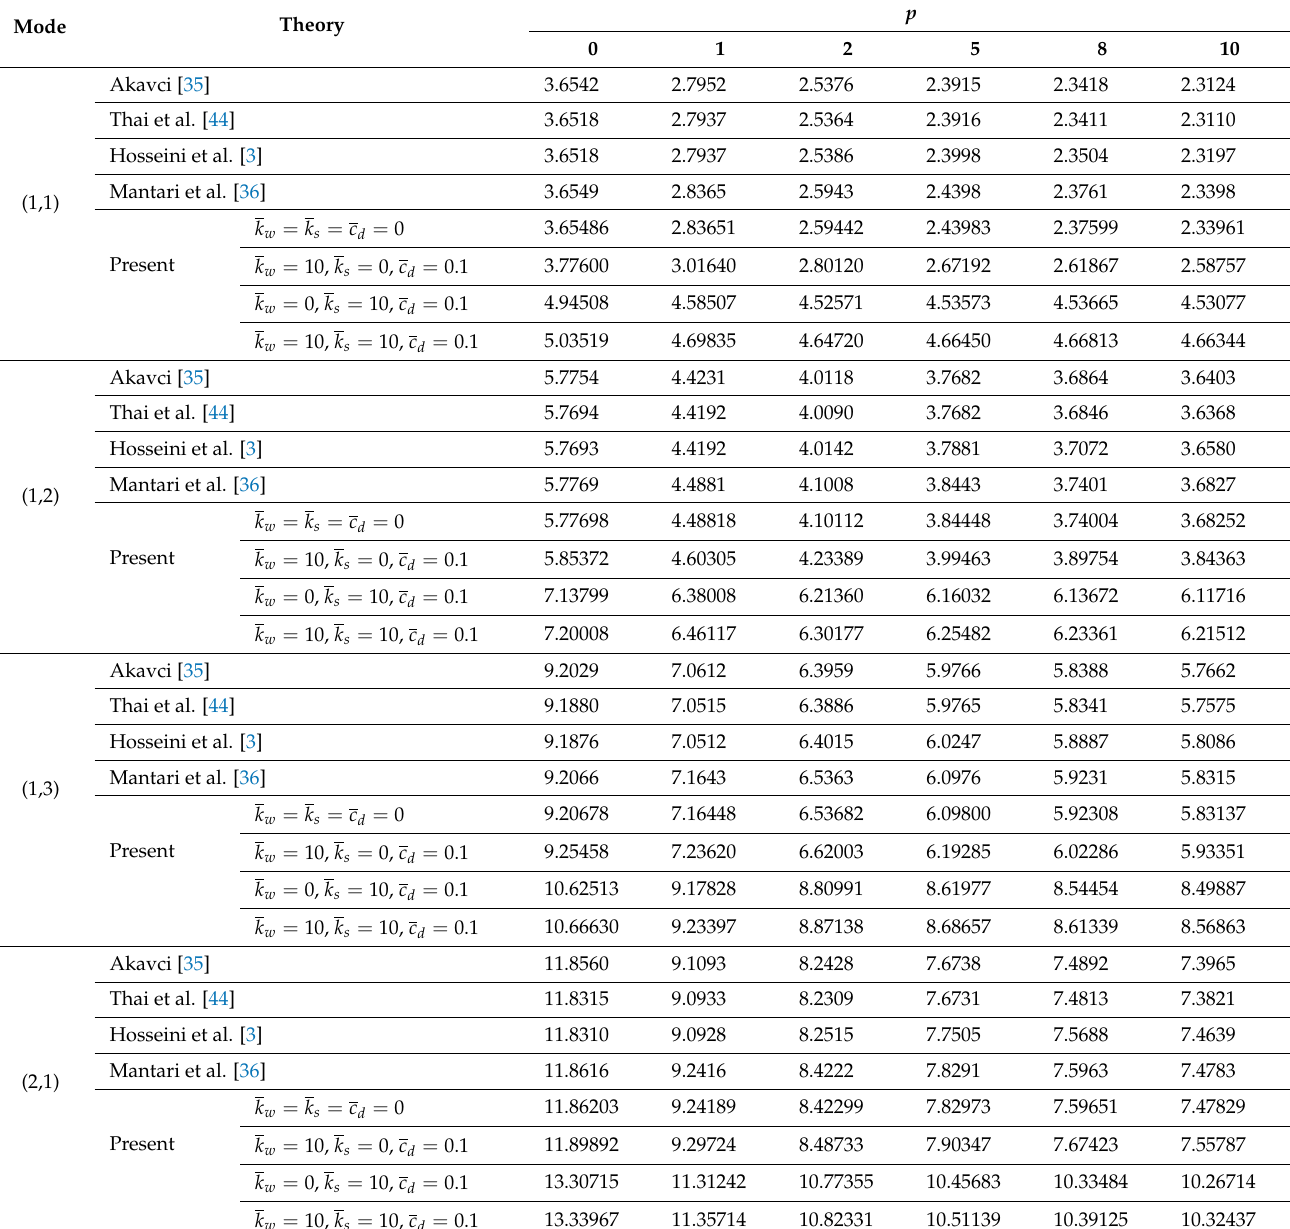
Table 9. Non-dimensional natural frequencies ˘ ω = plates on Visco-Winkler-Pasternak foundations ( b / a = 2, a / h =